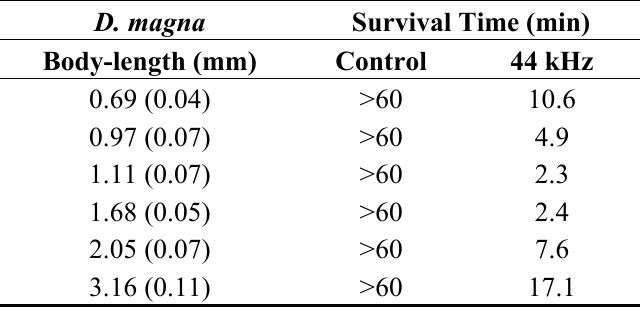
Table 1. Mean survival time (min) of Daphnia magna in six cohorts varying in size (0.7–3.2 mm, ±1 SD) exposed to ultrasound (44 kHz) or not exposed (Control). Survival time in treatments (44 kHz) was determined with Kaplan-Meier Survival